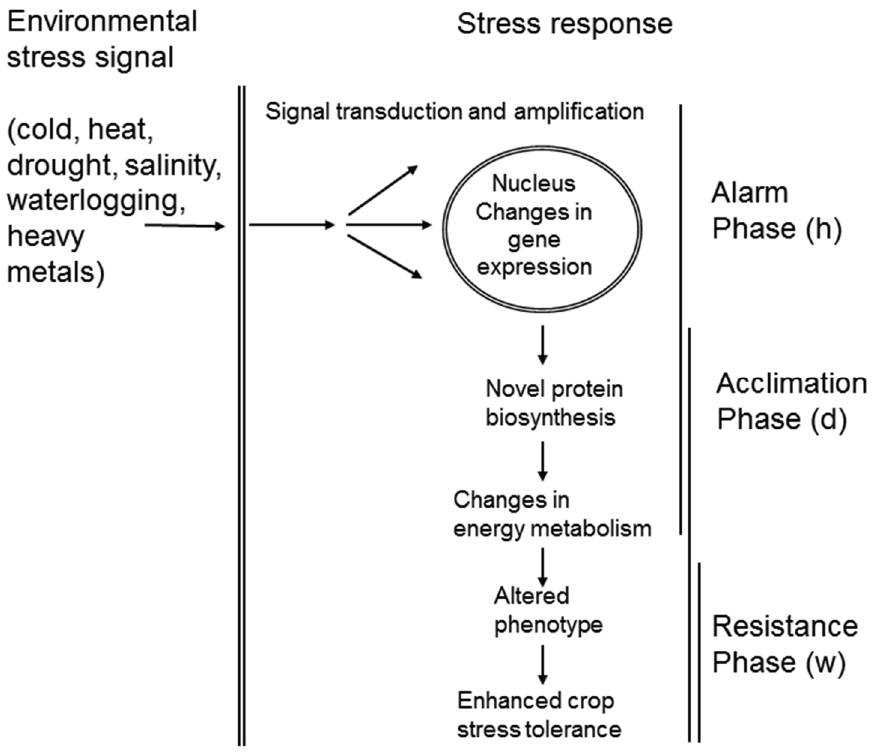
Figure 1. A schematic representation of the dynamics of plant stress perception and stress response at cellular level. The first phase of plant stress response, an alarm phase, is usually very short (hours; h) with respect to the following acclimation phase (days; d) and resistance phase (weeks; w). There are also significant overlaps between the individual processes and phases with respect to their